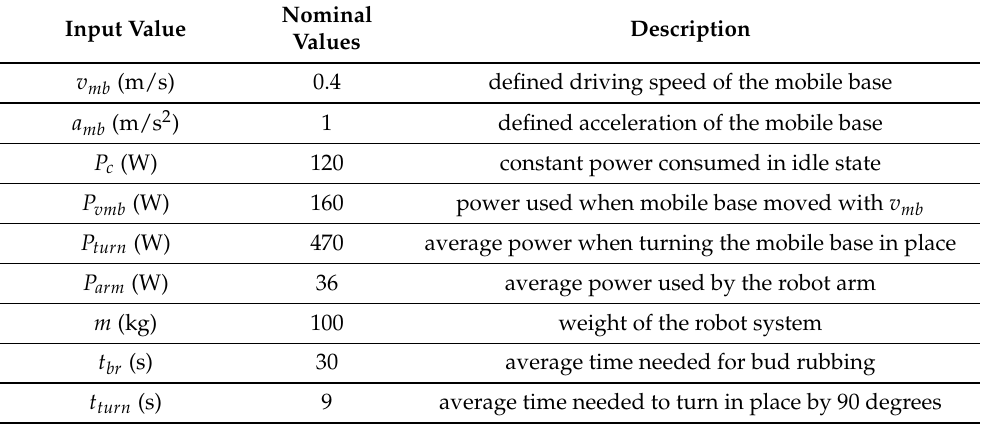
Table 2. Input values of key robot system variables and parameters used for energy consumption